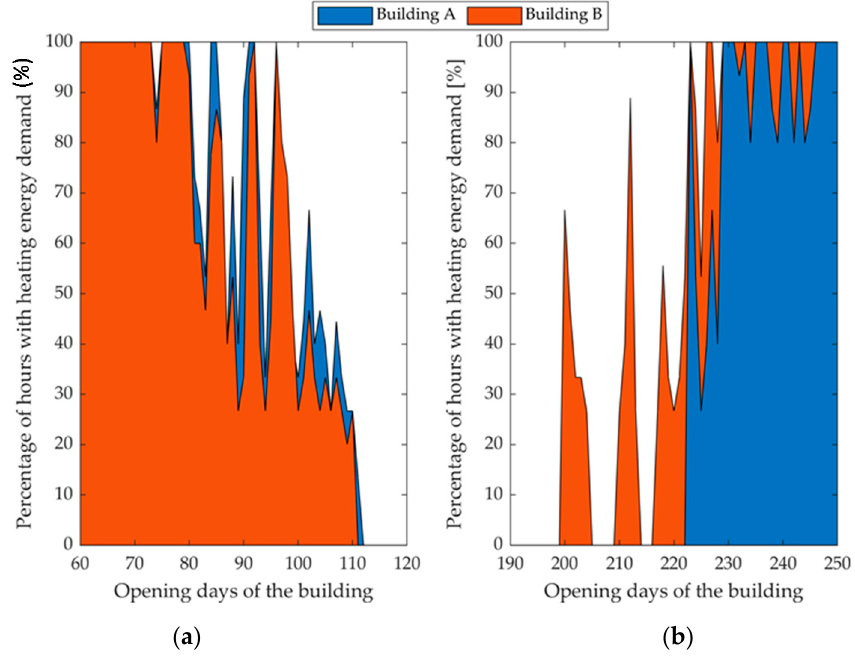
Figure 6. Percentage of heating hours for mid-season period: spring ( a ) and autumn ( b ).